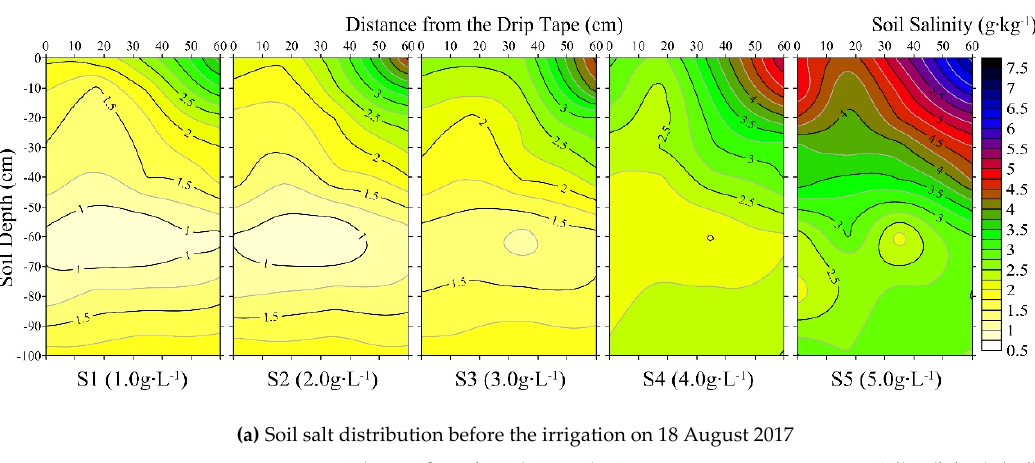
(f) Ash content Figure 7. The grain quality of maize in 2016 and 2017. Note: The same letter above the error bars in same year represents no significantly different at p ≤ 0.05.